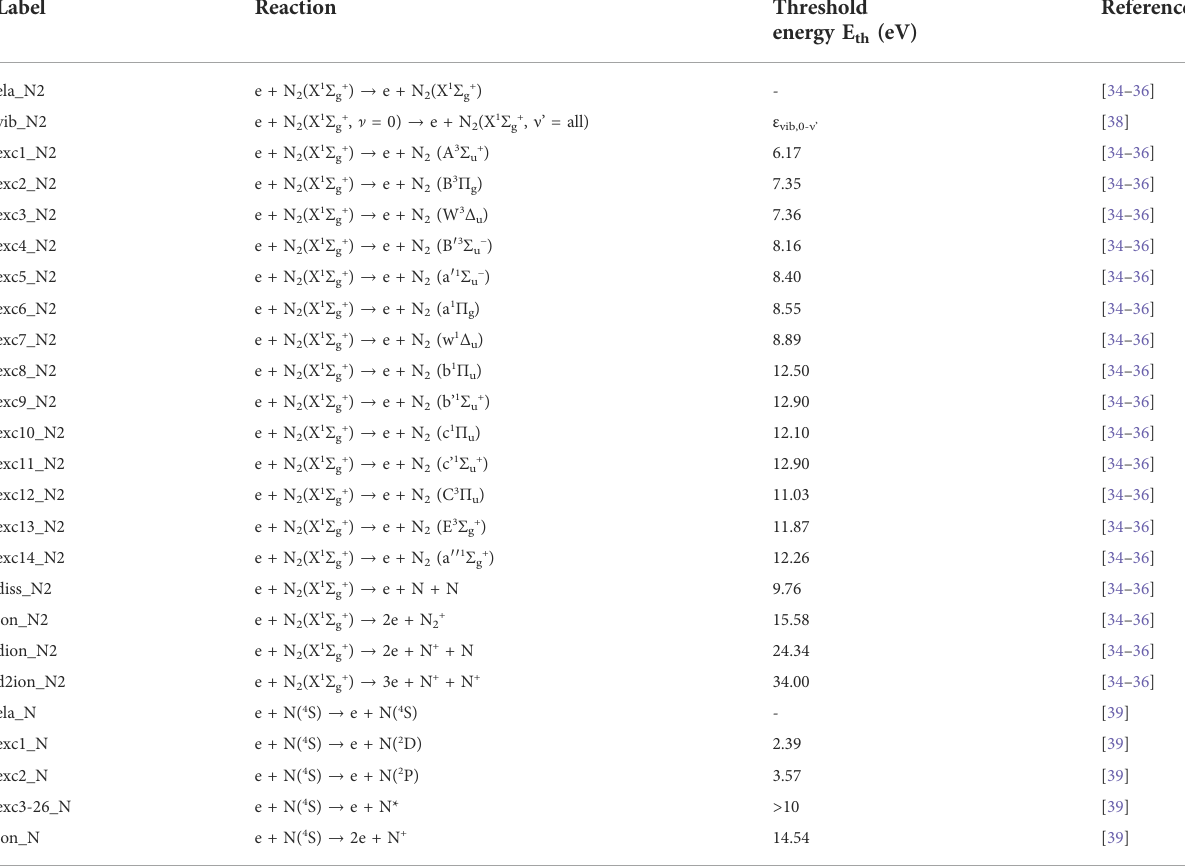
TABLE 2 Reactions between electron and the neutral nitrogen species (N 2 and N) considered in the proposed PIC-TPMC model. Label Reaction Threshold